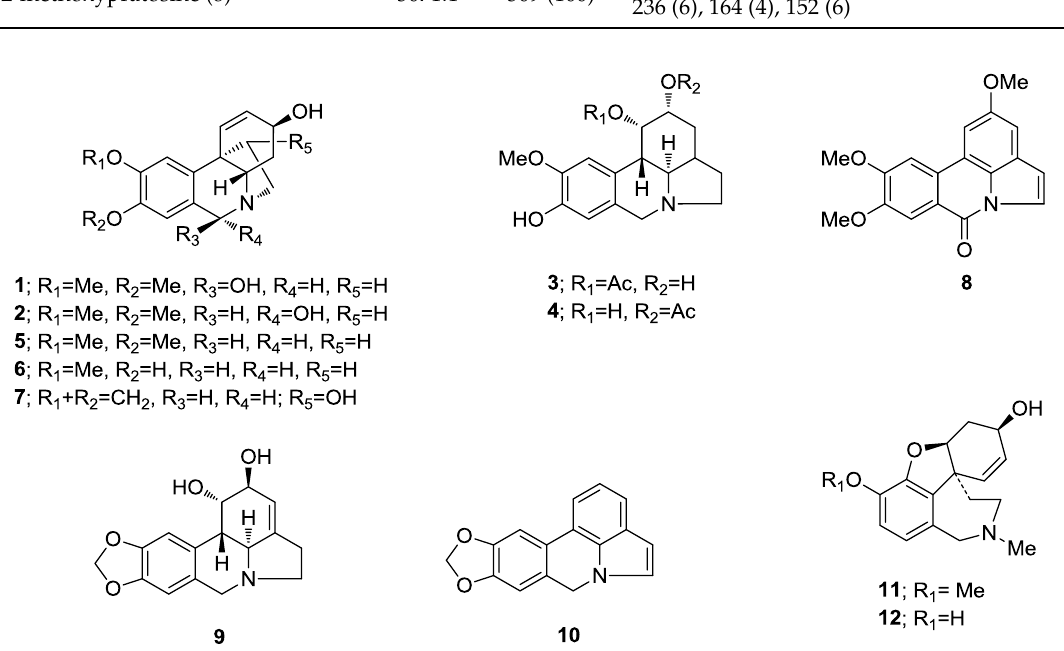
Figure 1. Alkaloids identified in H. reticulatum .